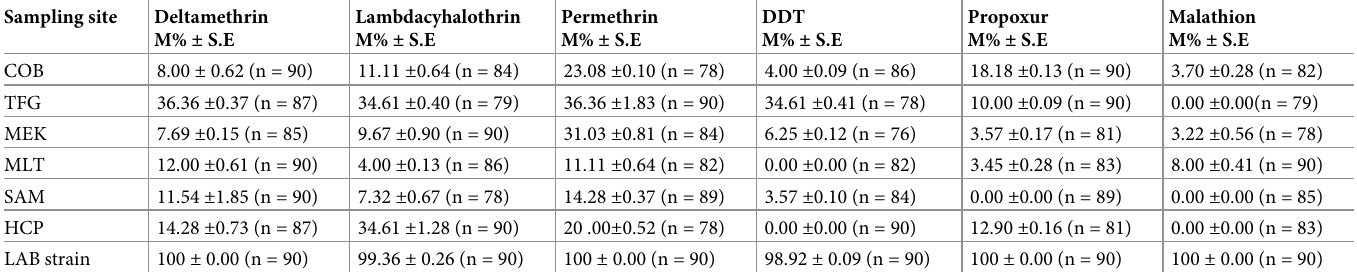
Table 2. Mortality rate (in percent) of Cx . quinquefasciatus from Coochbehar and Malda districts against six insecticides. M%- mortality percentage; S.E- Standard error; n-total number of mosquito adults. Sampling site